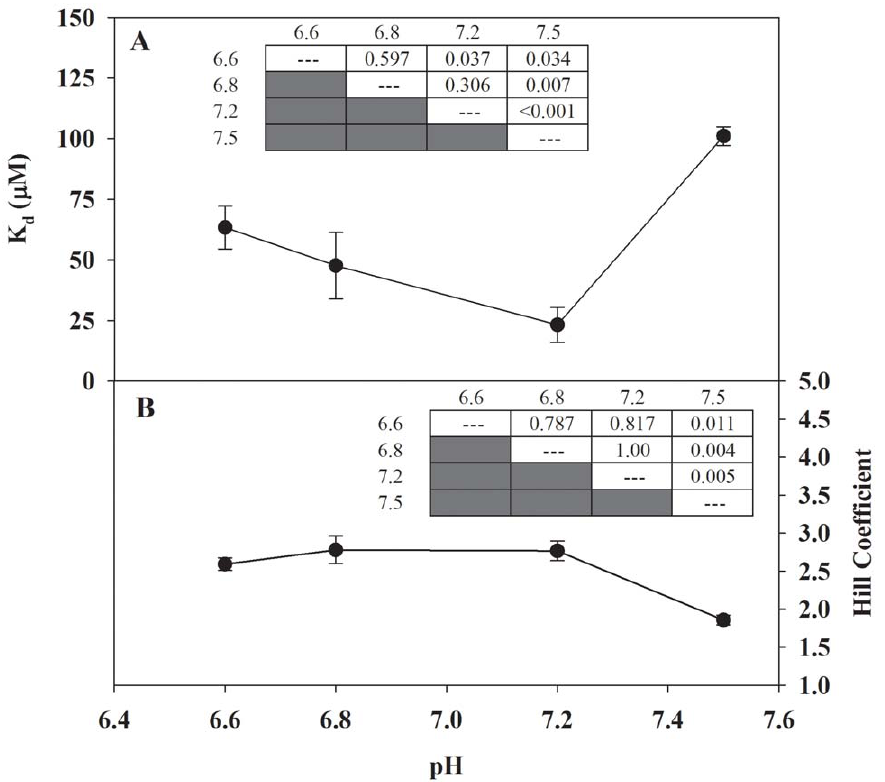
Figure 5. Effect of pH on the apparent dissociation constant (Panel A) and Hill coefficient (Panel B) of Ca 2 + -binding by FCSQ. Each data point represents a minimum of three protein preparations run in triplicate. Significant differences were determined using one way ANOVA followed by Tukey HSD multiple pairwise comparisons with significance set at 5%. Inset tables show P values from all pairwise comparisons. Error bars represent S.E.M.